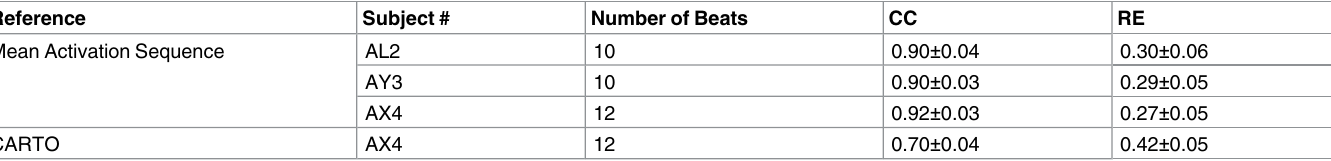
Table 2. Quantitative evaluations using the mean activation sequence and CARTO as the references. CC = Correlation coefficient; RE = Relative error.